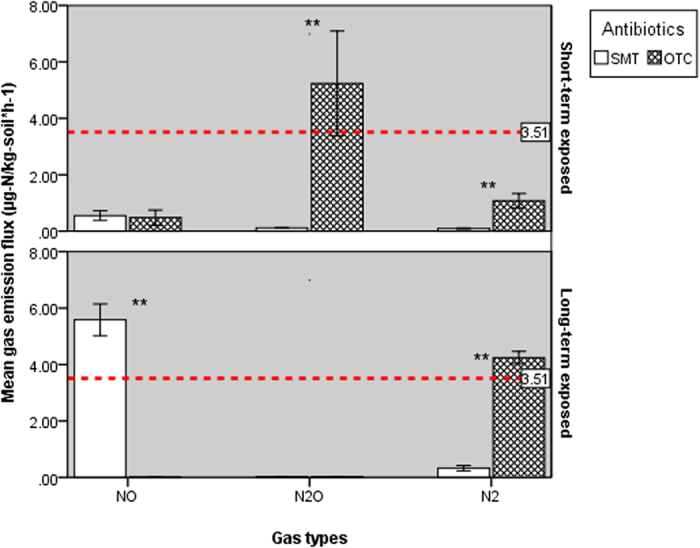
Mean nitrogen oxides (NO and N2O) and N2 gas emission flux over the period of experiments (n = 4).The error bars indicate standard deviation (±2 SD); a statistical significance (p < 0.01, one-way ANOVA) between the mean values was labeled with double asterisks (**). The dash line indicates the mean N2 flux of raw landfill refuses after the injection of leachate (without addition with antibiotics, 3.51 ± 0.61 μg-N/kg-refuse·h−1); the emission fluxes of NO and N2O from this control group were both <0.1 μg-N/kg-refuse·h−1).